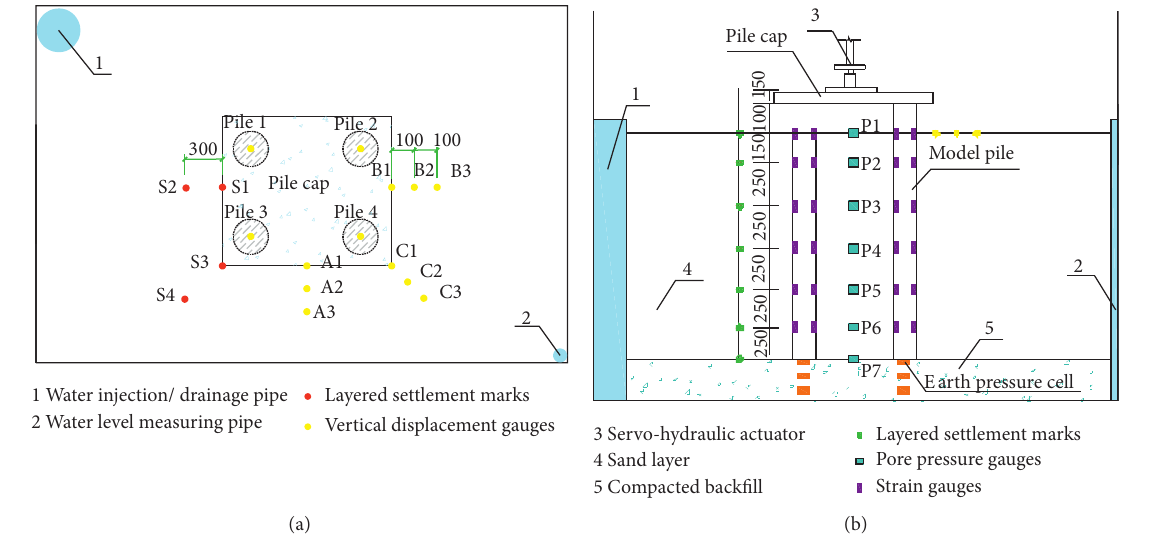
Figure 2: Layout of model test. (a) Plan view. (b) Longitudinal sectional view. Table 1: Parameters of soil for the test.